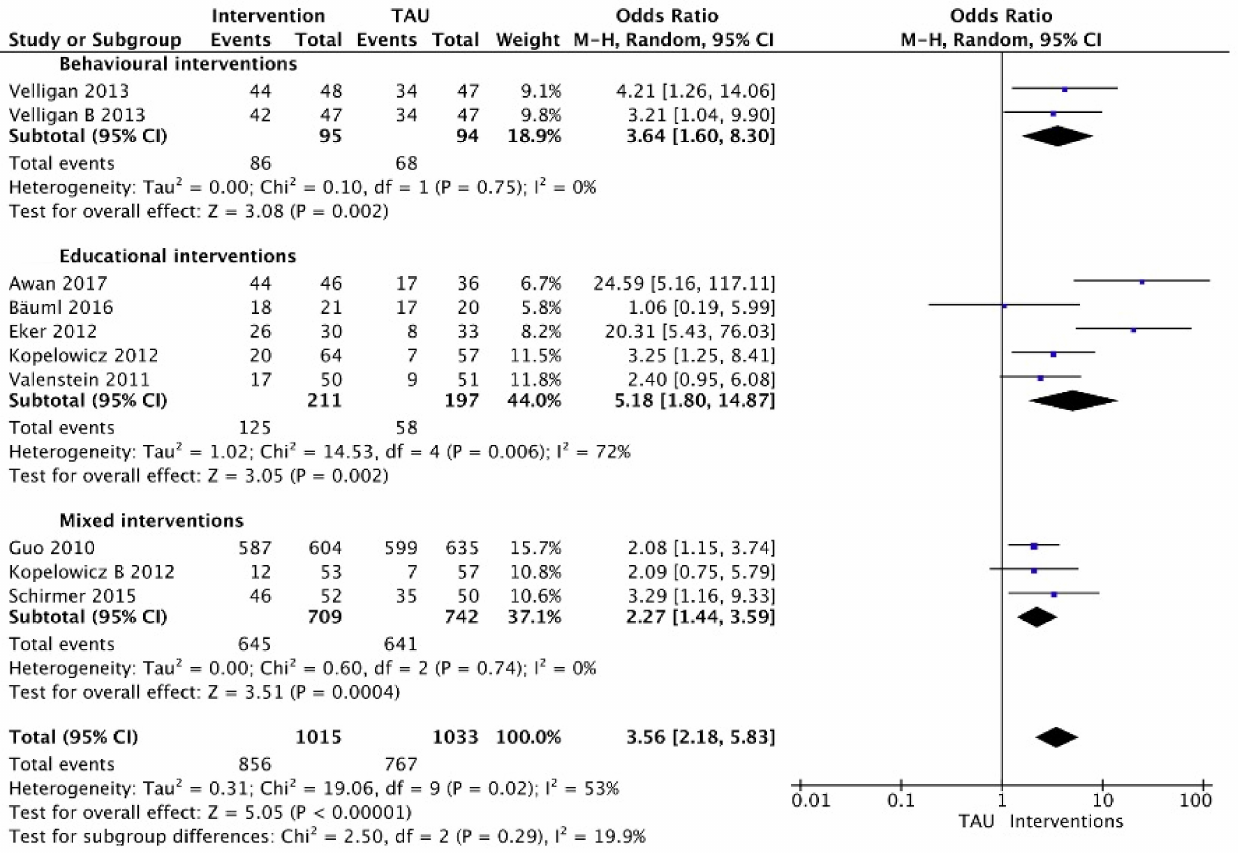
Figure 2. Interventions versus usual care grouped by type of intervention (dichotomous).